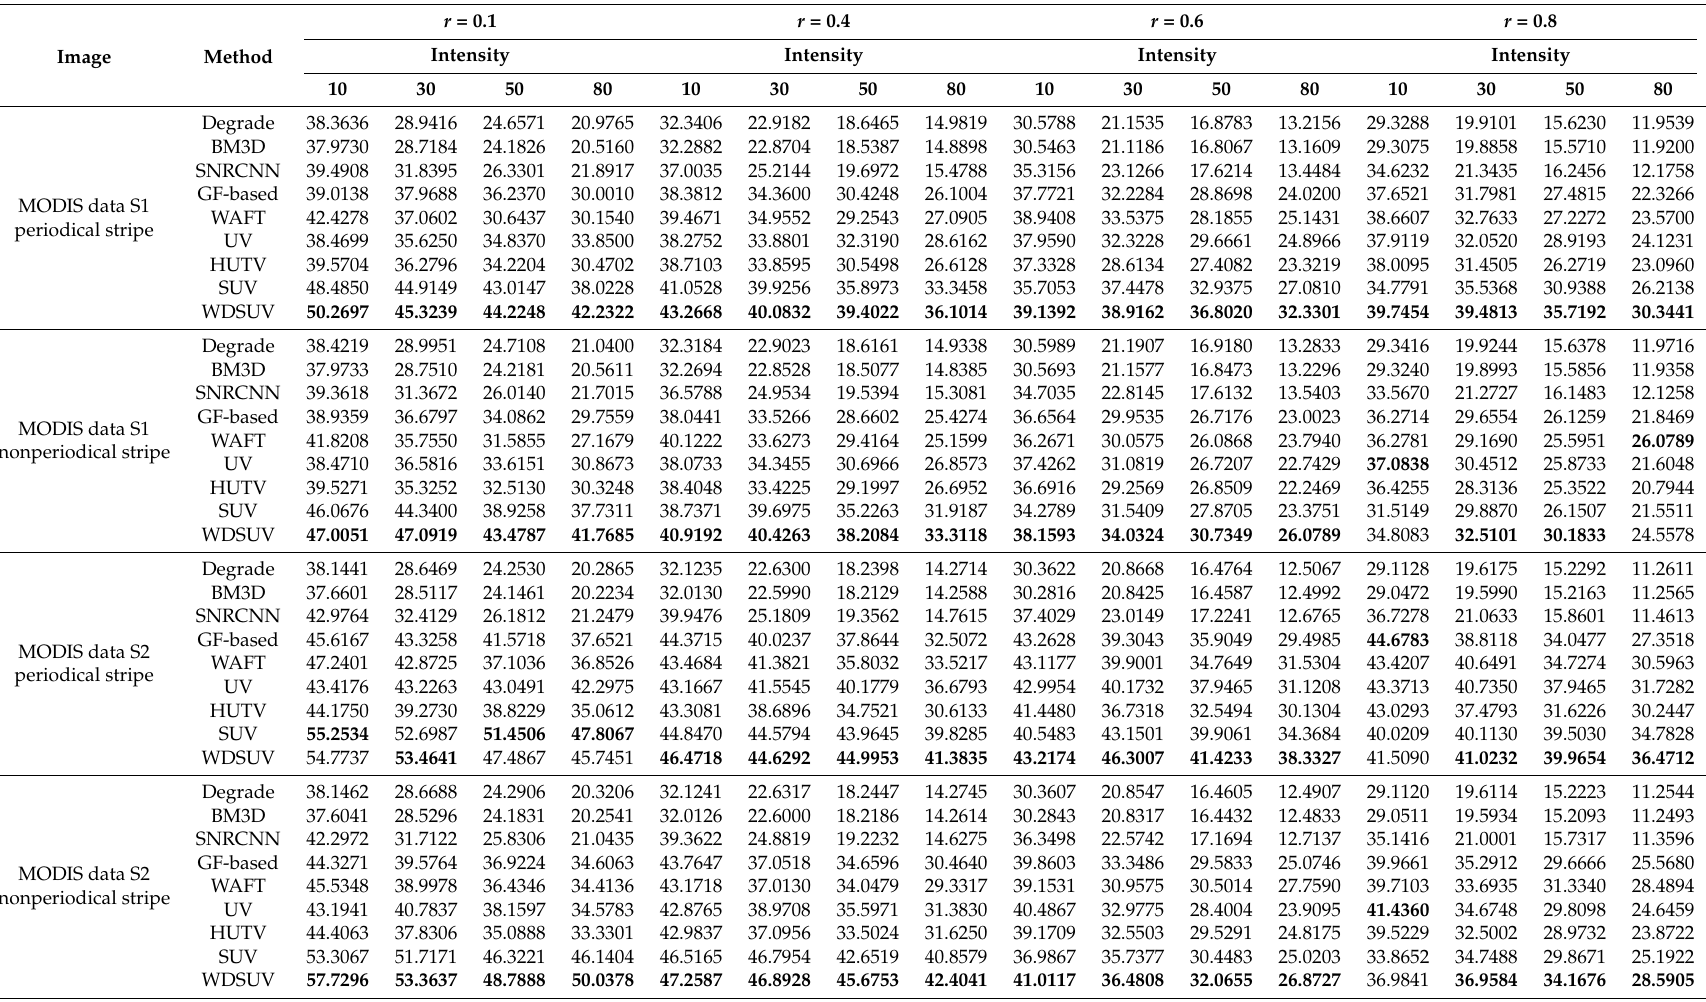
Table 2. Peak signal-to-noise ratio (PSNR) index results of different methods on simulated data under various noise